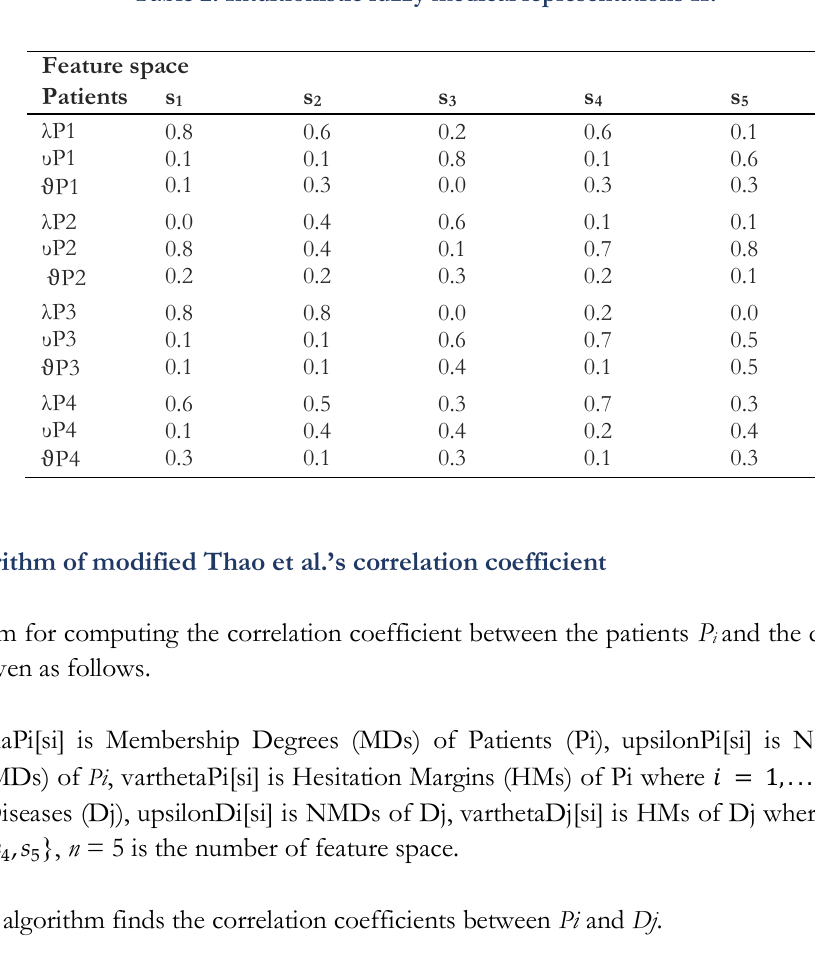
Table 2. Intuitionistic fuzzy medical representations